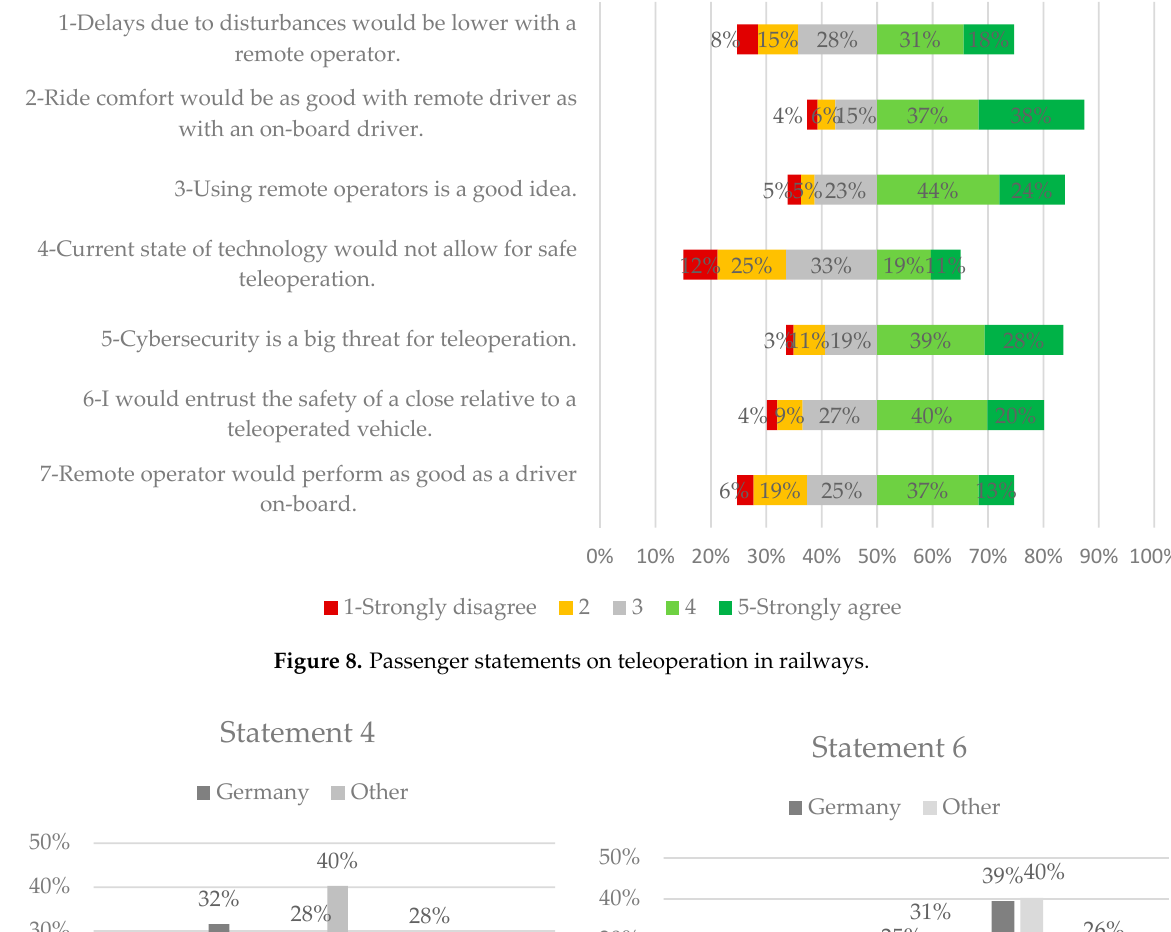
8 Figure 7. Acceptable levels of safety for driverless vehicles with remote operation as fallback system. The last question of the first part of the survey collected responses to statements on several aspects of teleoperation. Figure 8 below shows the distribution of answers. Statement 4 has the most equally distributed responses compared to the other statements. Thirty-three percent of respondents are unsure about the state of the technology for safe